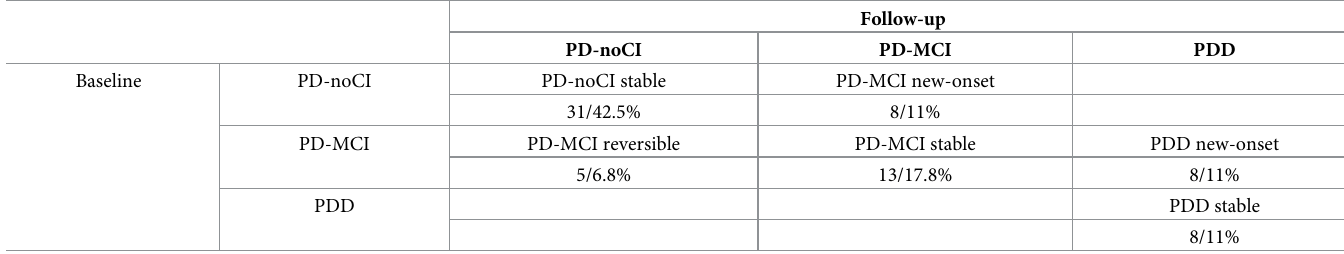
Table 1. Cognitive diagnosis of patients at baseline and